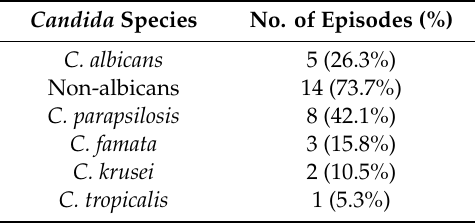
Table 3. Distribution of Candida